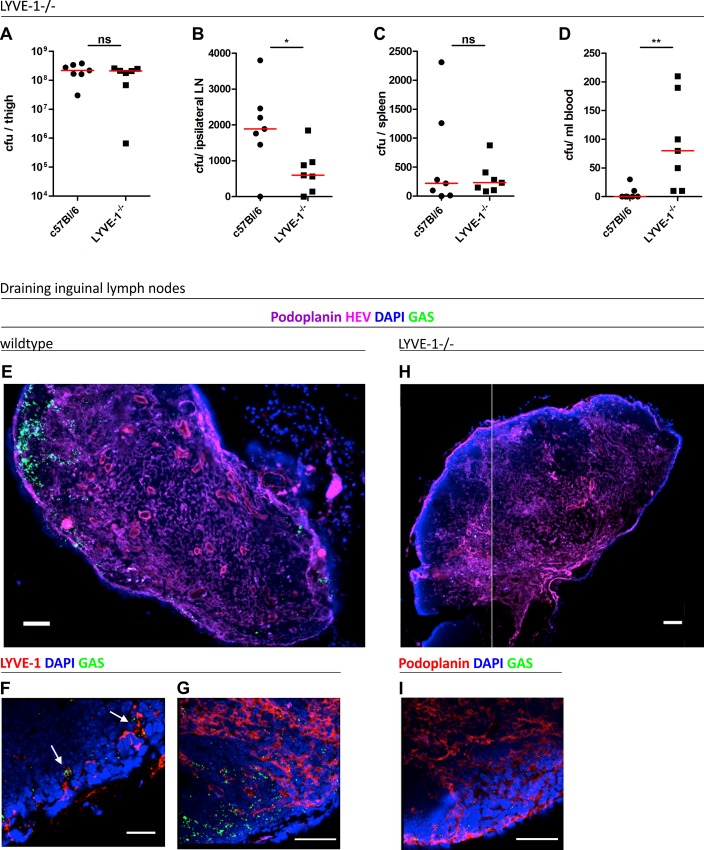
Genetic deletion of LYVE-1 impairs GAS dissemination to draining lymph nodes.Dissemination of M18 GAS in murine soft-tissue infection in constitutive LYVE-1-/- mice (n = 7/group). Numbers of GAS recovered at site of infection (A), ipsilateral draining LN (B), spleen (C) and blood (D) 3 hours post-infection. Lines depict median values in each case (Mann Whitney U;* = p<0.05, ** = p<0.01). (E-I) Confocal micrographs of frozen sections of representative draining inguinal lymph nodes from wildtype (n = 5) (E-G) and LYVE-1-/- (n = 4) (H and I) mice that were resected 3 hours post infection. Original magnification was 100X (E and H) or 400X (F, G and I). Scale bars are 100, 50, 20, 100 and 50 μm for E, F, G, H and I respectively.